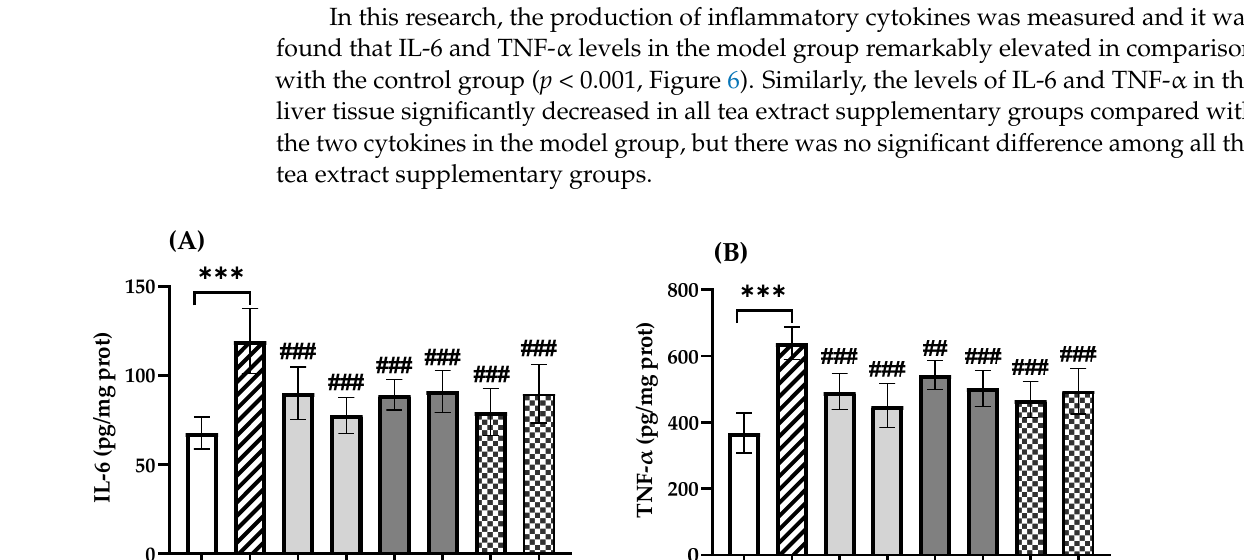
✱✱✱ Figure 5. The effects of teas on hepatic antioxidant capacity in mice exposed to chronic alcohol con-